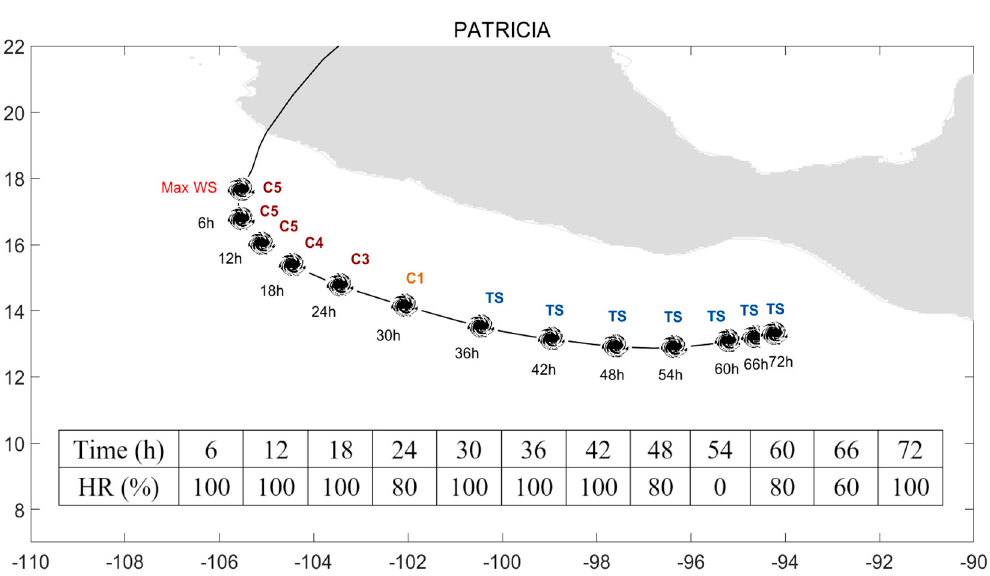
Figure 10. As in Figure 4, but for hurricane Patricia (NE Pacific Ocean, 20–24 October 2015). Here, the TS was formed on 21 October 2015, at 00:00 UTC and it reached the Max WS on 23 October 2015, at 12:00 UTC.